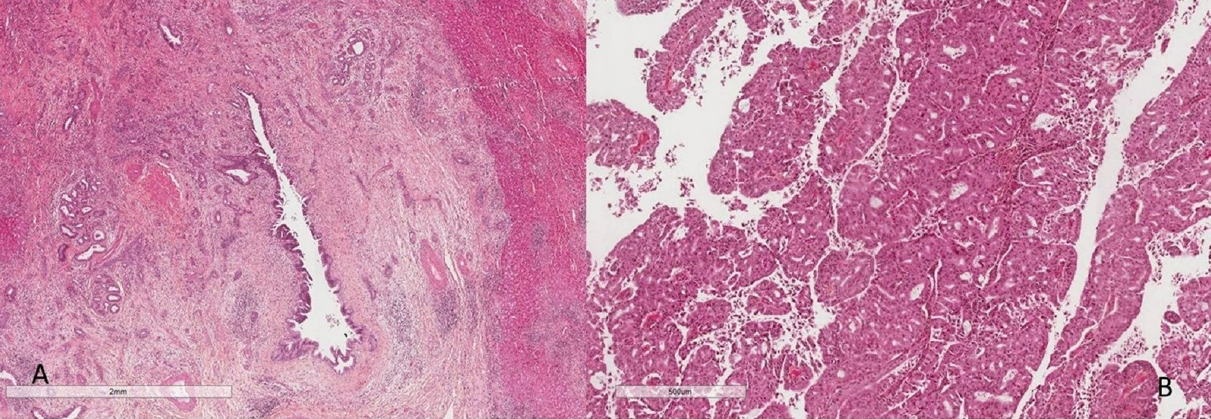
Figure 5. Microscopic aspect of periductal infiltrating ( A ) and intraductal growth ( B ) cholangiocarcinoma (HES staining ×100).